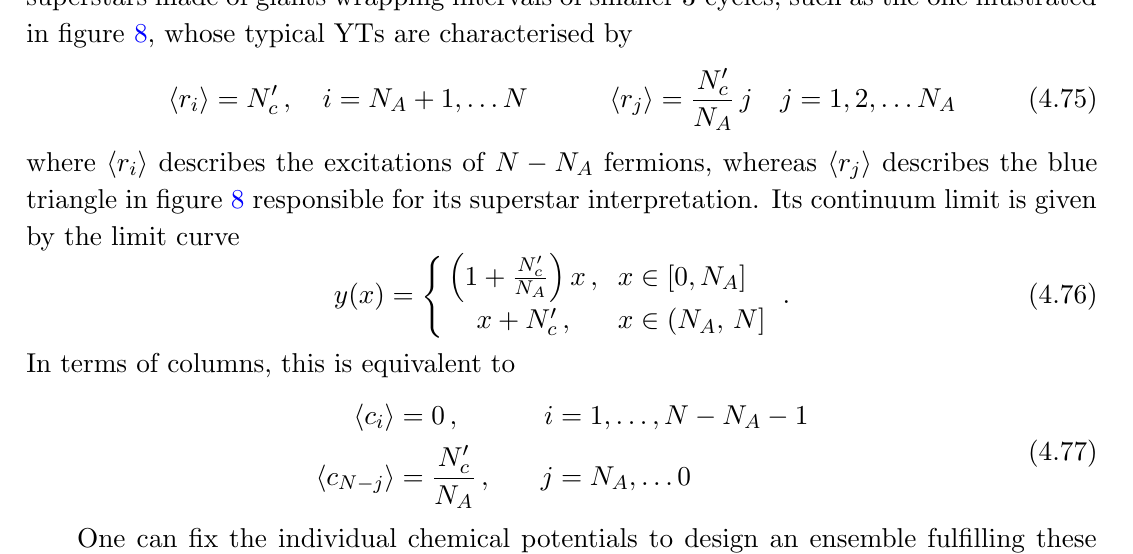
Figure 8 . Young tableau consisting of N A fermions describing a superstar with N 0 with the remaining N (cid:0) N A fermions having an N 0 Single localised superstar and a